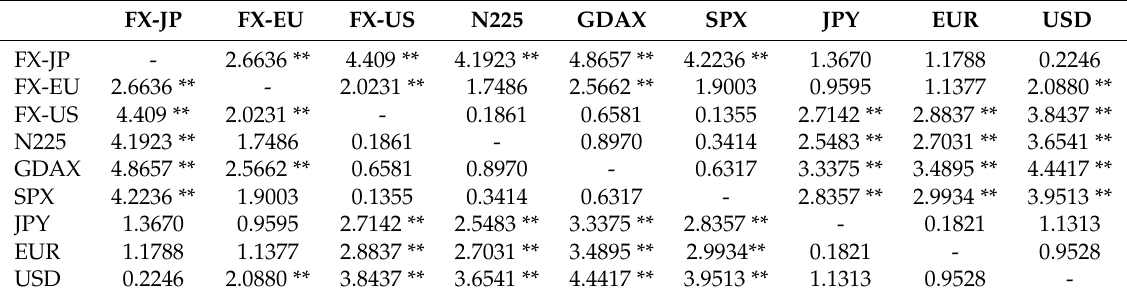
Table 3. Test statistics for common order of integration.